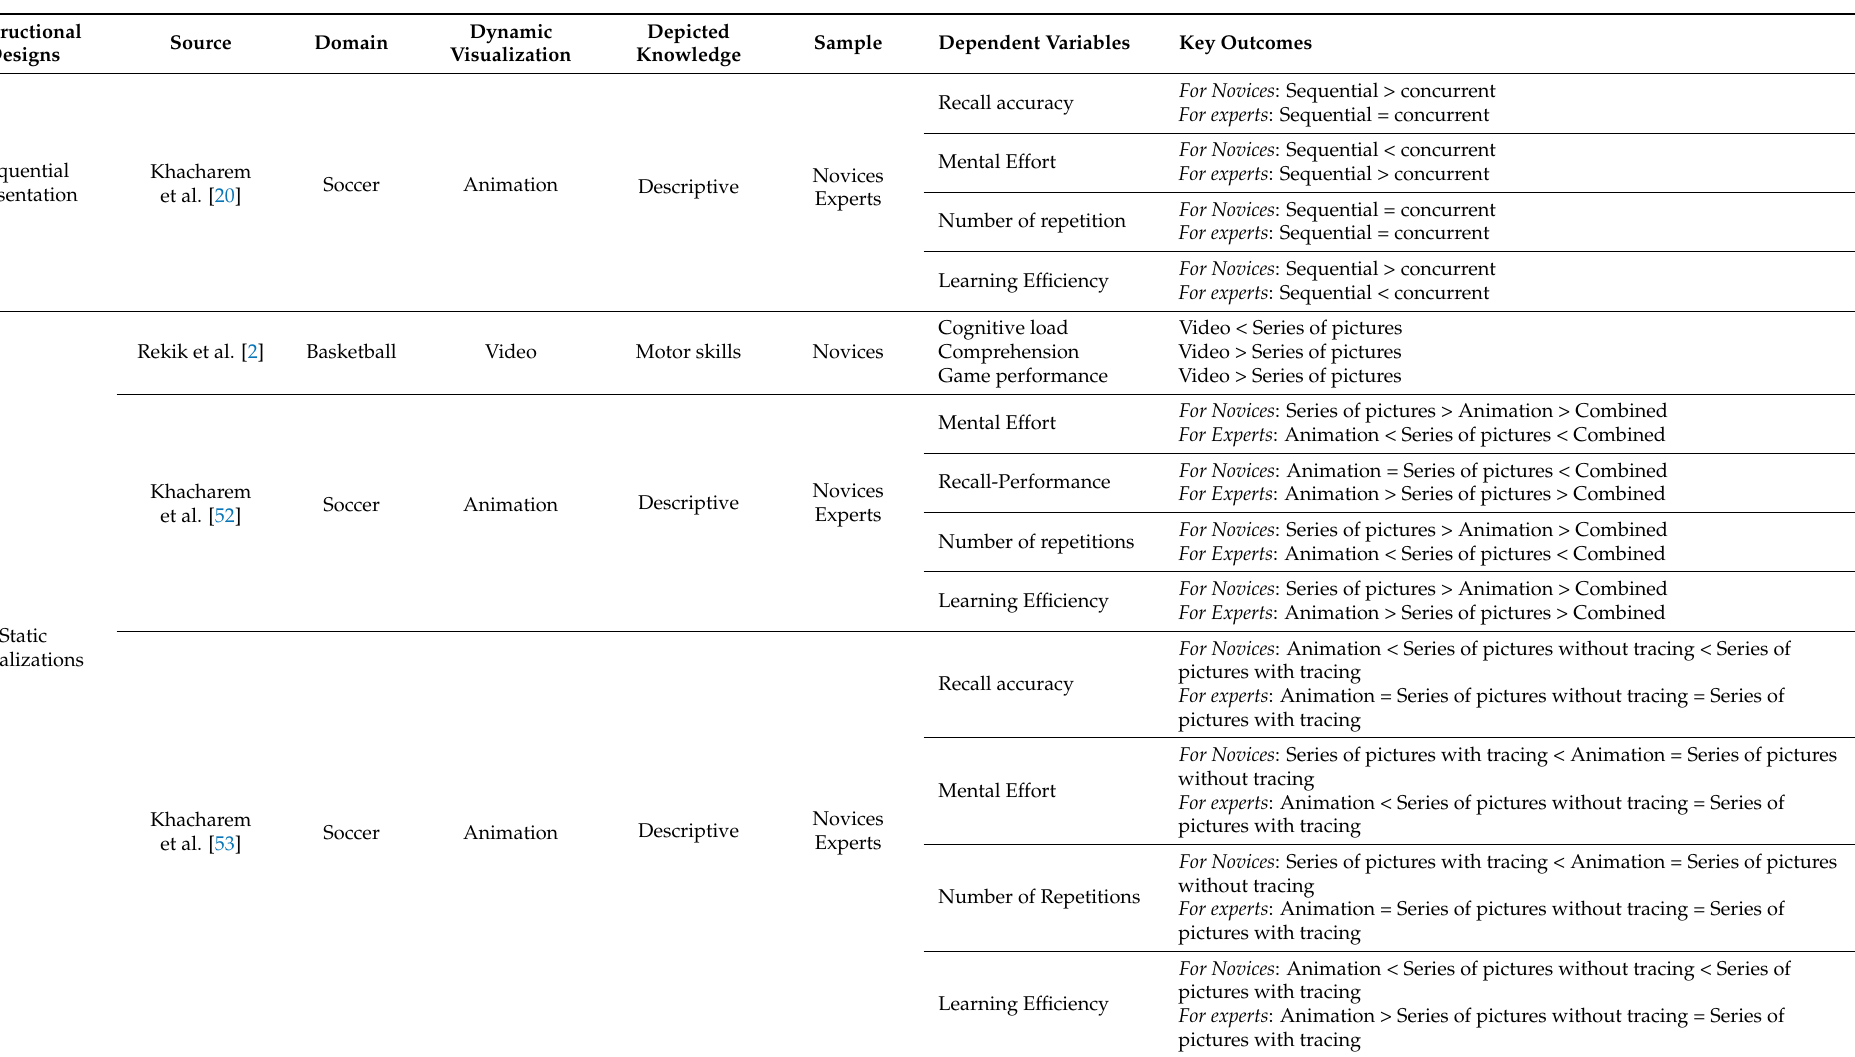
Table 2. Effects of instructional designs on learning tactical scenes of play through dynamic visualizations: overview of the analyzed